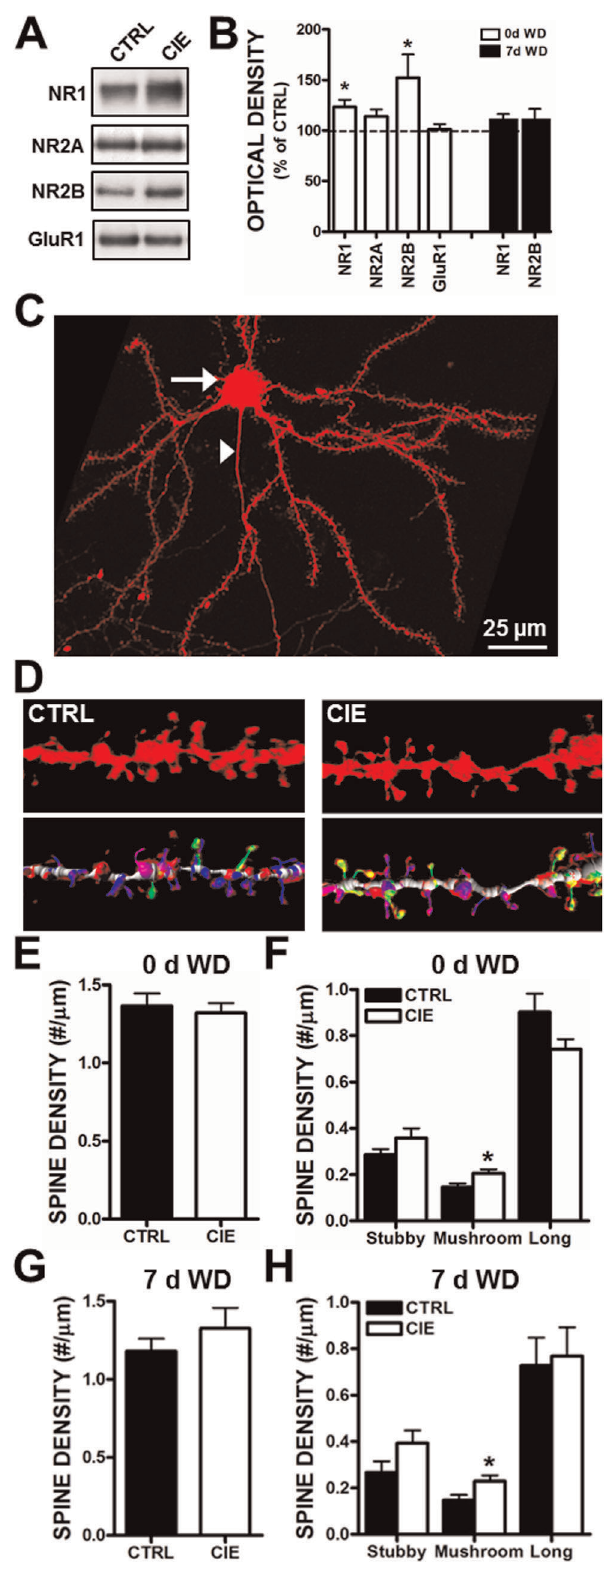
Figure 3. Chronic intermittent ethanol (CIE) increases the density of mature dendritic spines in layer V mPFC pyramidal neurons and produces a transient increase in NMDARs. A) Representative blots of NMDAR and AMPAR subunits in control and